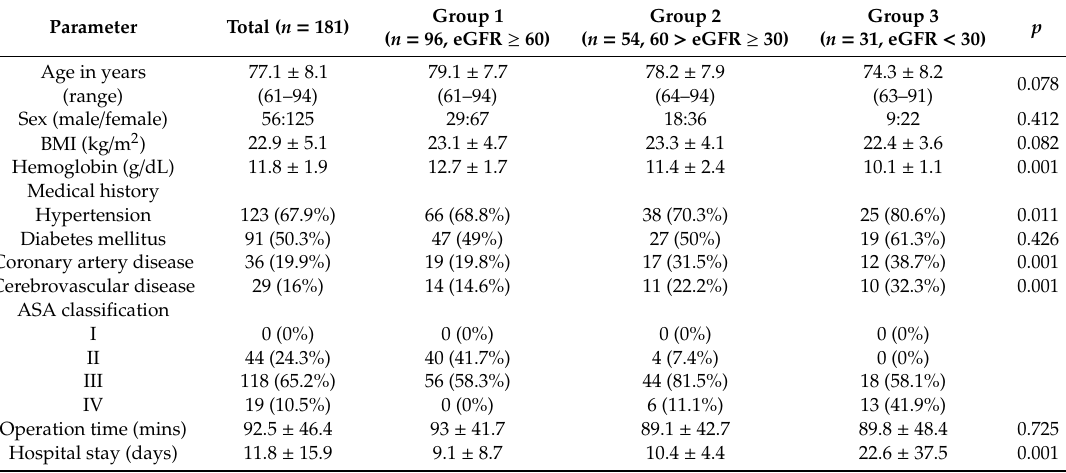
Table 1. Demographic